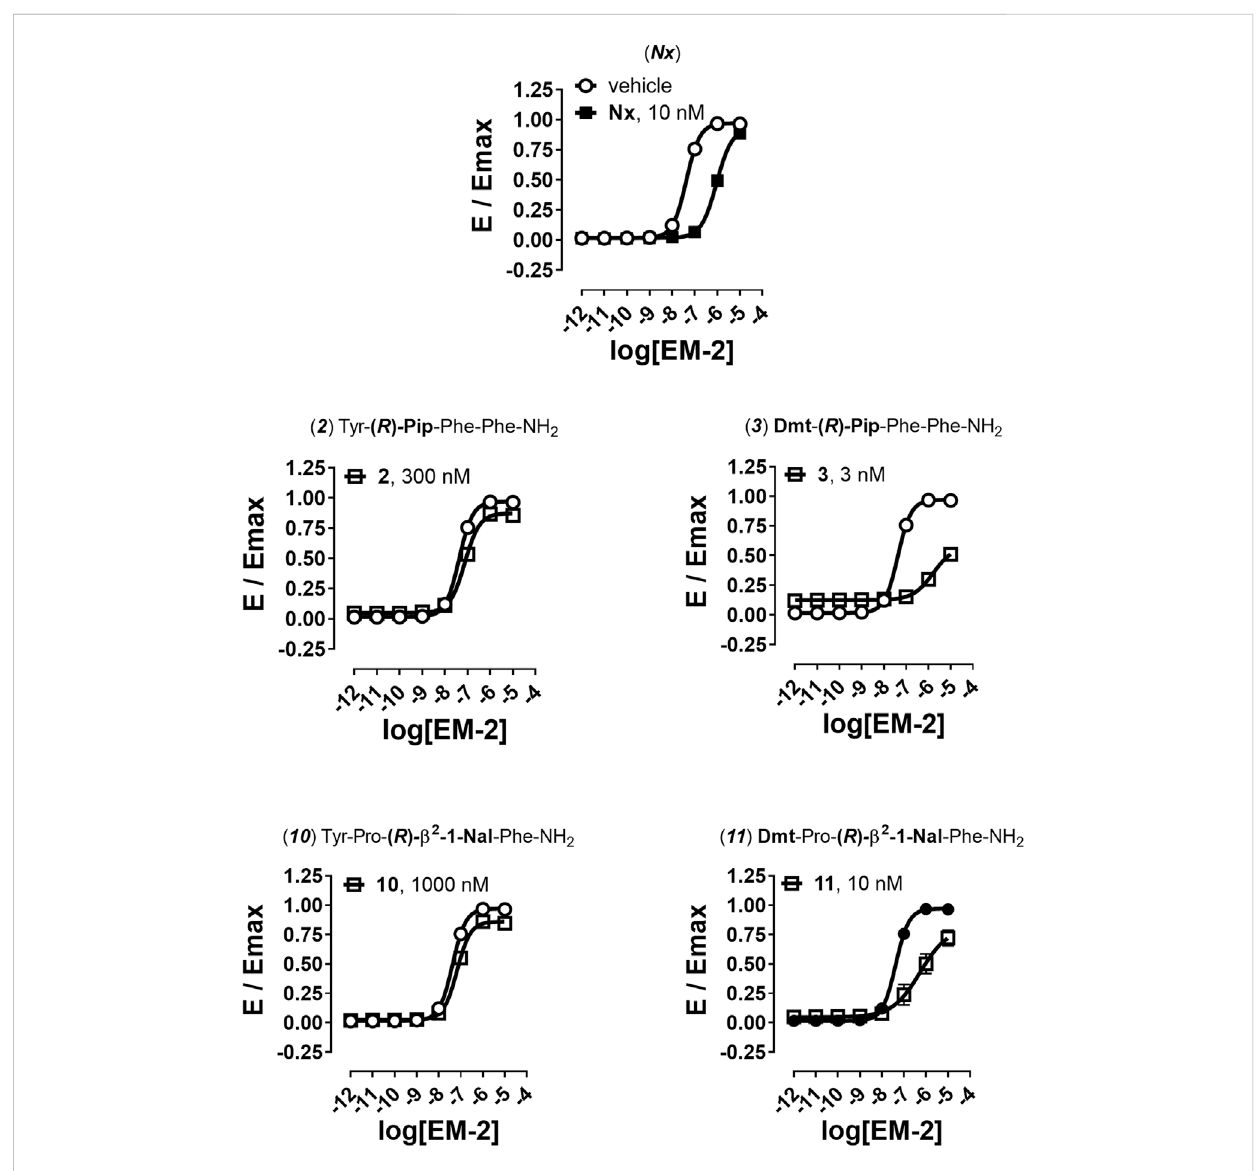
FIGURE 4 Antagonism experiments for β -arrestin 2 recruitment. Effects of Nx (10 nM), 2 (300 nM), 3 (3 nM), 10 (1,000 nM), and 11 (10 nM) in challenging EM-2 concentration-response curves in mu- β -arrestin 2 BRET interaction assay. Data are mean + sem of four independent experiments performed in duplicate.